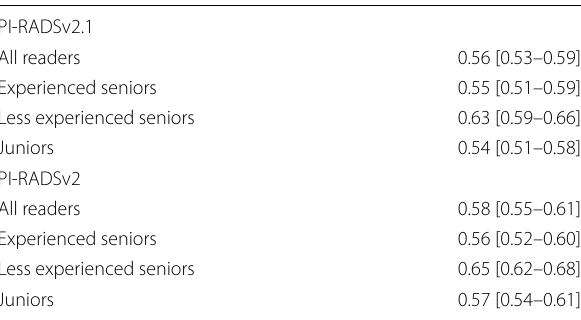
Table 5 Inter-reader agreement (per-lobe analysis)